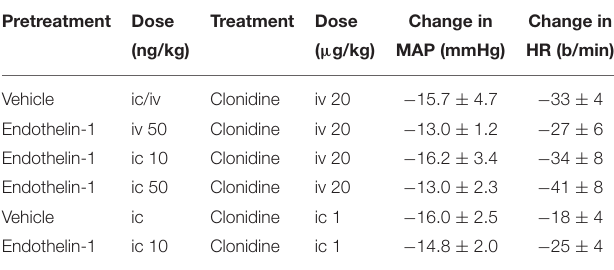
FIGURE 3 | Mean arterial pressure (MAP) and heart rate (HR) responses to intracisternal (ic) injection of clonidine (1 µ g/kg) over a 60 min time course following intracisternal pretreatment with vehicle (filled circle) or endothelin–1 (10 ng/kg, open triangle). C1 indicates initial basal values and C2 indicates MAP and heart rate 30 min after pretreatment injection. Error bars, as for Figure 1 . TABLE 1 | Changes in mean arterial pressure (MAP) and heart rate (HR) induced 15 min following clonidine administration in vehicle or endothelin-1-pretreated